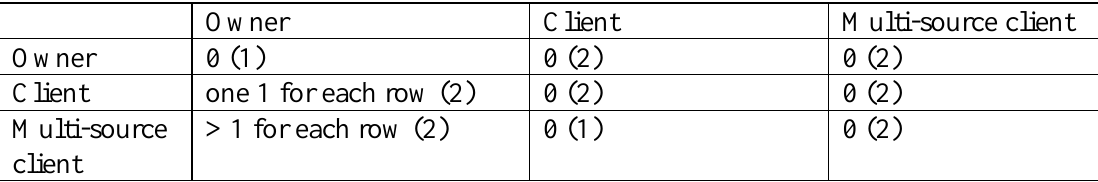
Table A1.1: Image matrix for the defined three groups owners, clients and multi-source clients. Penalties to deviations are presented in